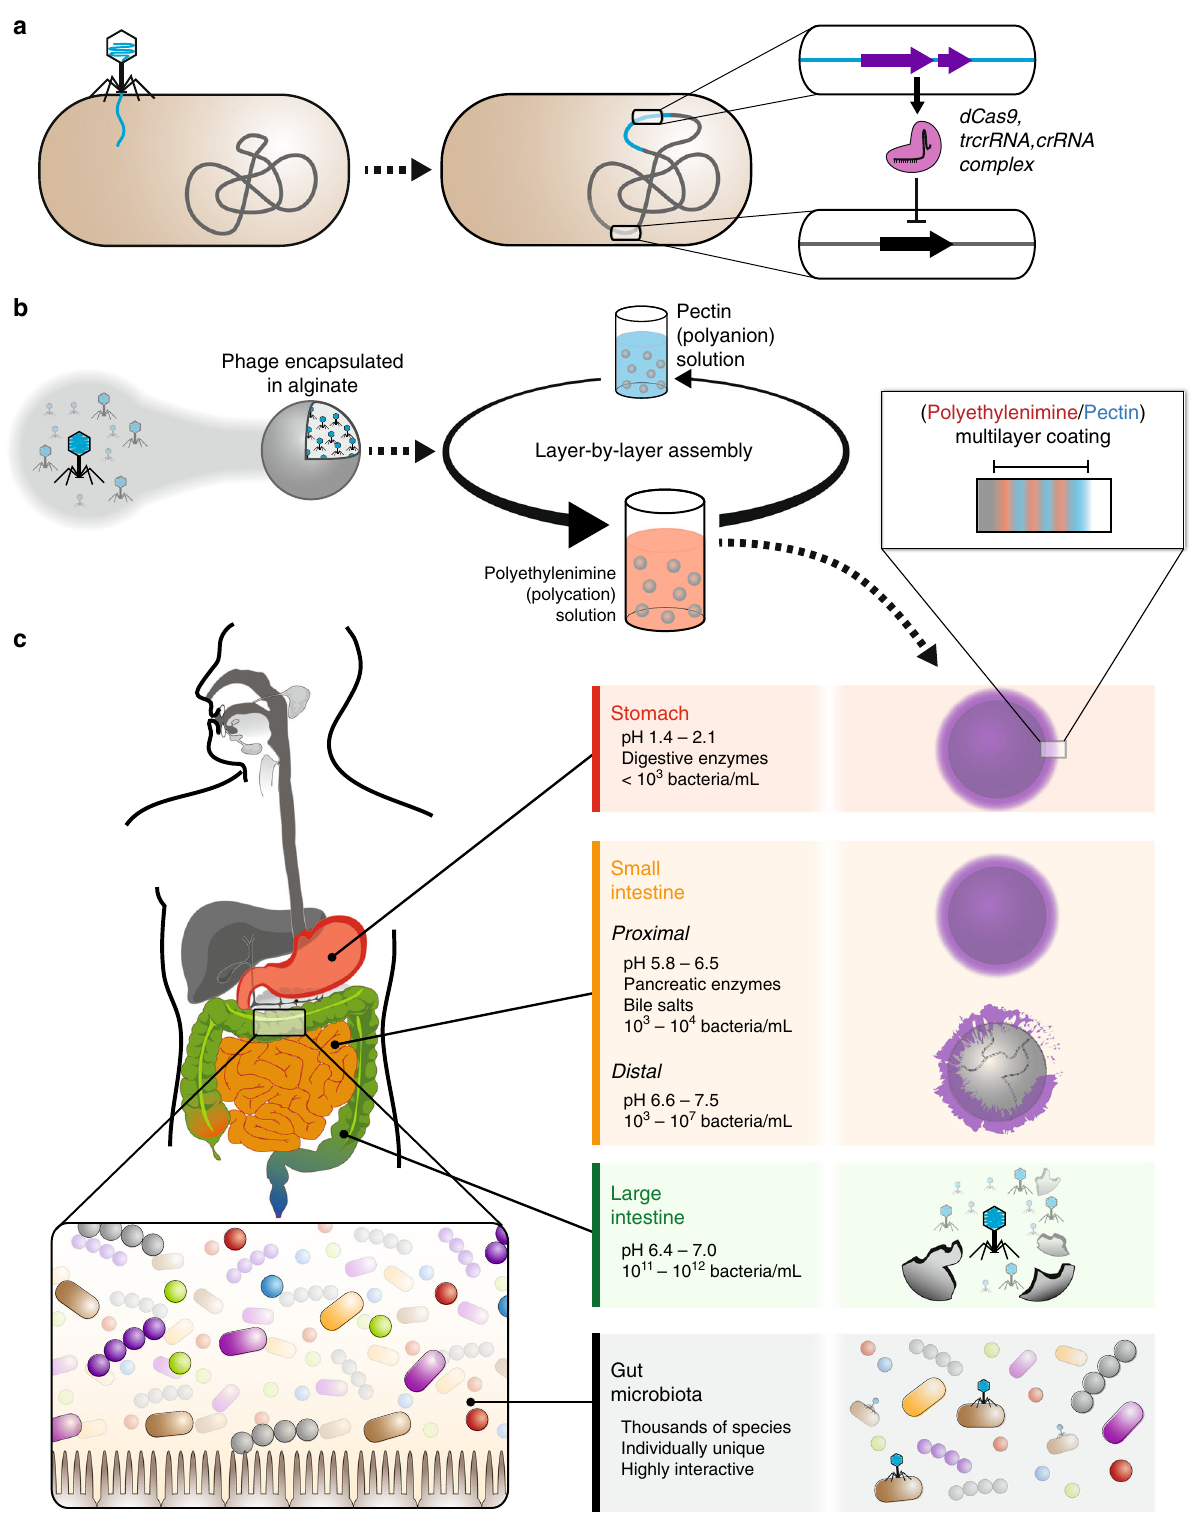
Fig. 1 In situ modi fi cation of gut bacteria by oral delivery. Temperate phage is engineered to express dCas9, trcrRNA, and crRNA so that speci fi c bacterial genes can be repressed ( a ). The encapsulation strategy uses calcium-mediated crosslinking of a sodium alginate solution to produce beads, which are coated in a polymeric multilayer ( b ). The digestive system has longitudinal variations in pH 27,40 and bacteria 41 , and presents multiple challenges to biological therapeutics during their transit through the stomach, small intestine, and large intestine ( c